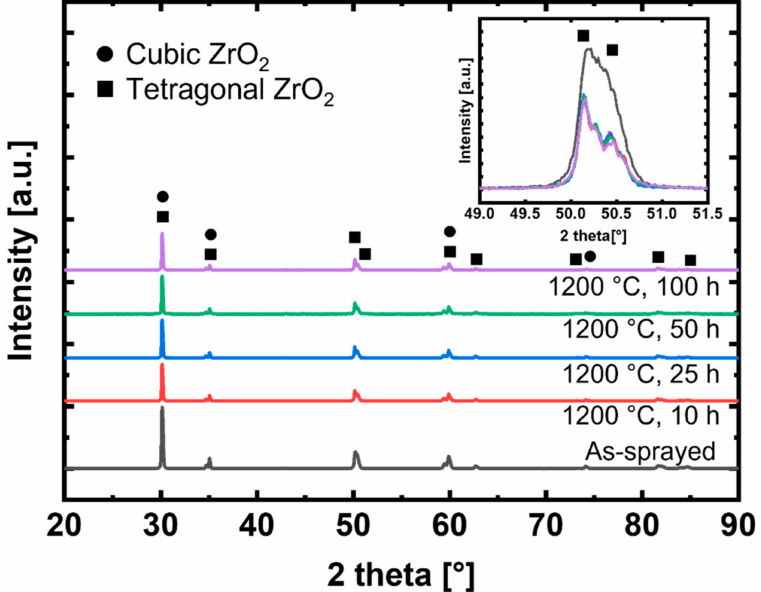
Figure 3. XRD spectra of as-sprayed and heat-treated 7YSZ coatings at 1200 ◦ C. (inset) Magnified XRD spectra from 49 to 51.5 ◦